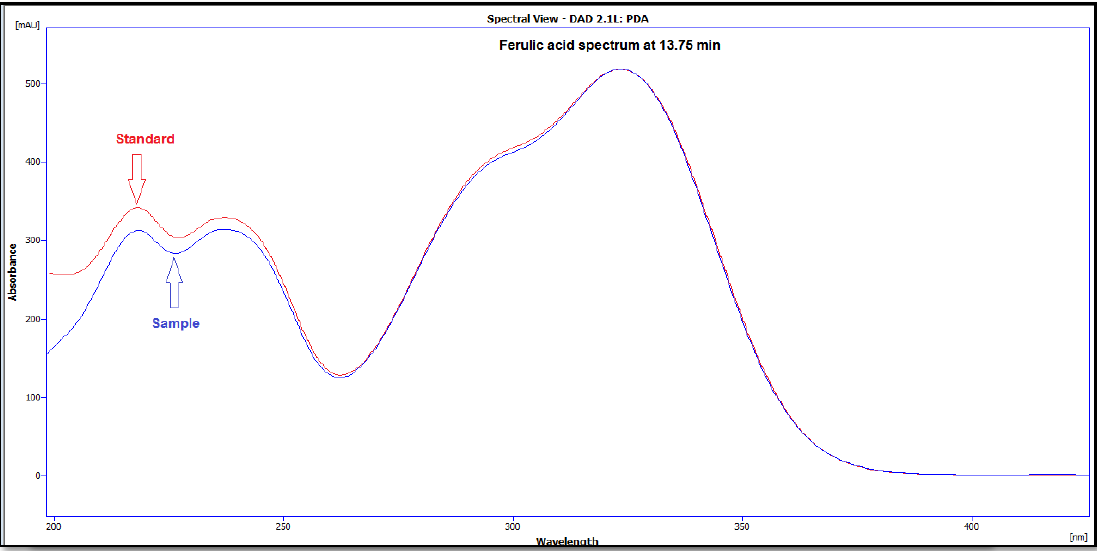
Figure 10. UV spectroscopy of standard and sample chlorogenic acid at